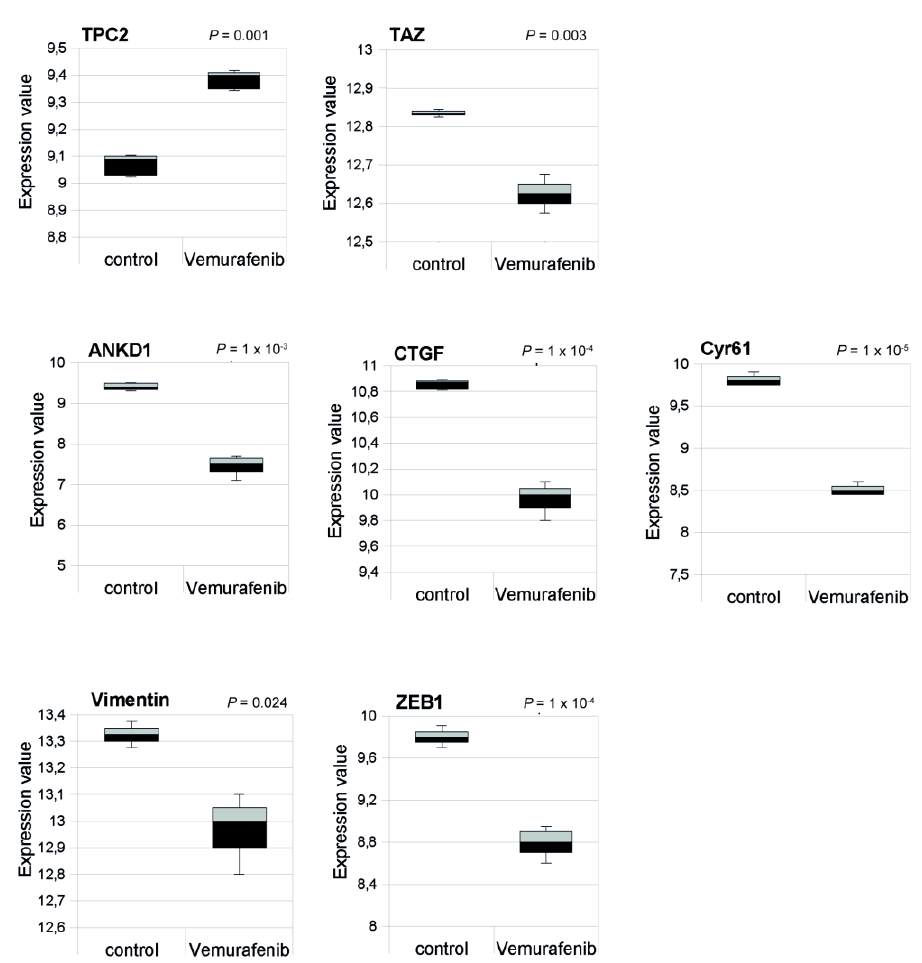
Figure 6. Analysis of A375 melanoma cells harbouring the BRAF V600E oncogenic mutation following treatment with the BRAF inhibitor Vemurafenib.